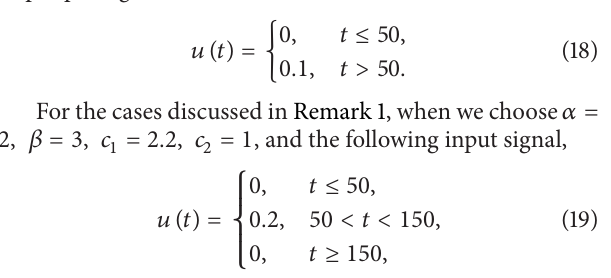
function 𝑦(𝑡) = 𝑥 1 (𝑡) . For 𝑘 = 5 , all the state variables in